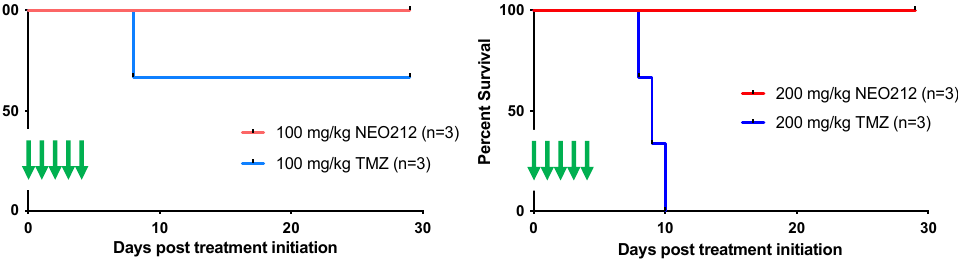
Figure 9. High-dose NEO212 does not impact survival. Three rats per group received one 5-day cycle of daily treatments with NEO212 or TMZ. Shown is survival of animals after treatment with 100 mg/kg per dose ( left panel ) and 200 mg/kg per dose ( right panel ). Green arrows indicate treatment days.